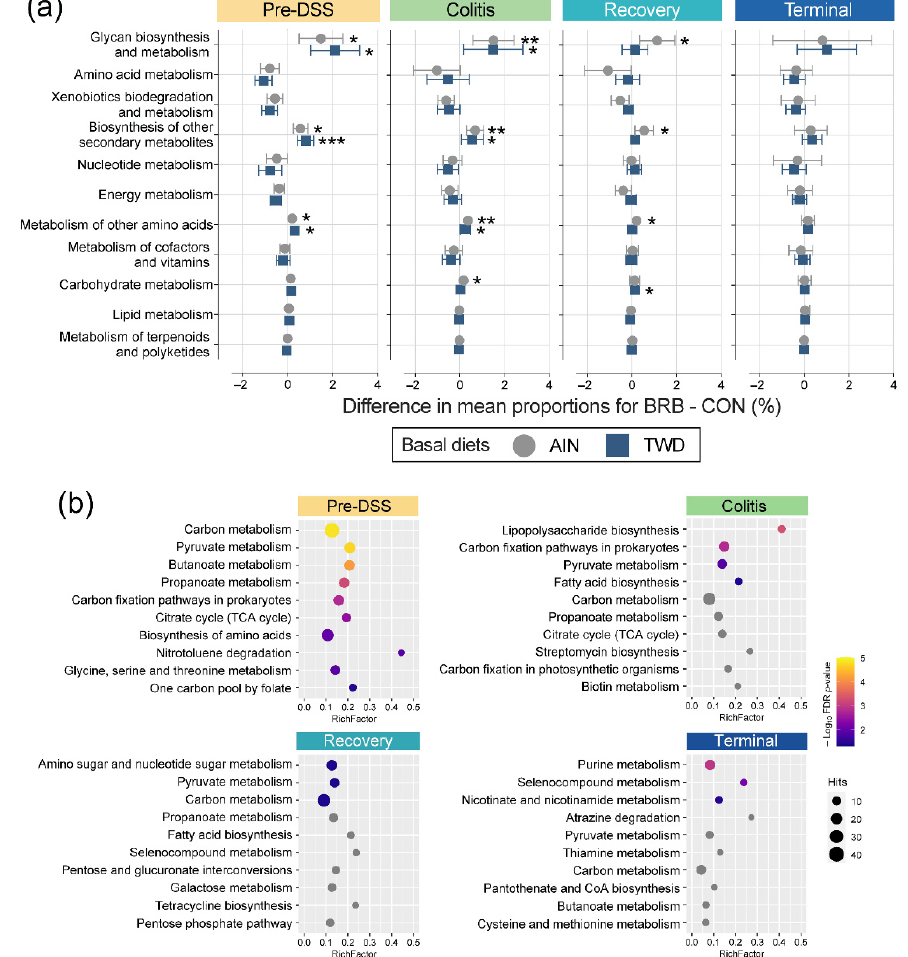
Figure 13. Metagenome predicted functions classified using KEGG metabolism orthology with tax4fun (experiment B). ( a ) Differences in mean proportions for BRB-supplemented and CON treat- ments for mice fed either AIN or TWD basal diets. Values are the differences between proportions with 95% confidence intervals. *, p < 0.05; **, p < 0.01; and ***, p < 0.001, as determined by Fisher’s exact test followed by Benjamini–Hochberg method to adjust for multiple comparisons for the full data set. Proportions for each diet and supplement combination at each time point are provided in Figure S13b. ( b ) Pathway enrichment of significant KEGG level 2 terms associated with the fecal microbiome of BRB-fed mice (AIN- and TWD-fed combined). Values shown are the term count (number of terms associated with the metabolism pathway), the enrichment factor (number of sig- nificant terms/total terms in pathway) and the FDR-corrected p -value.